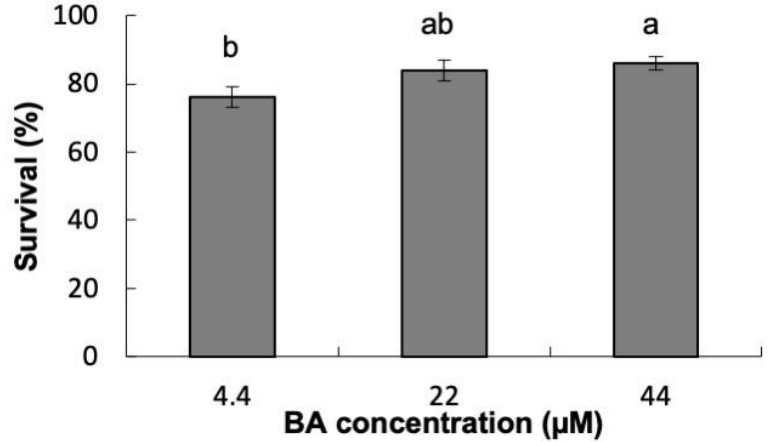
Figure 1. Percentage of survival of Pinus ponderosa explants cultured in LP or half LP macronutri- ents (Quoirin and Lepoivre [24], modified by Aitken-Christie et al. [25]), supplemented with 6-benzyladenine. Data are presented as mean values ± S.E. Different letters indicate significant differences according to Tukey’s post hoc test ( p < 0.05).